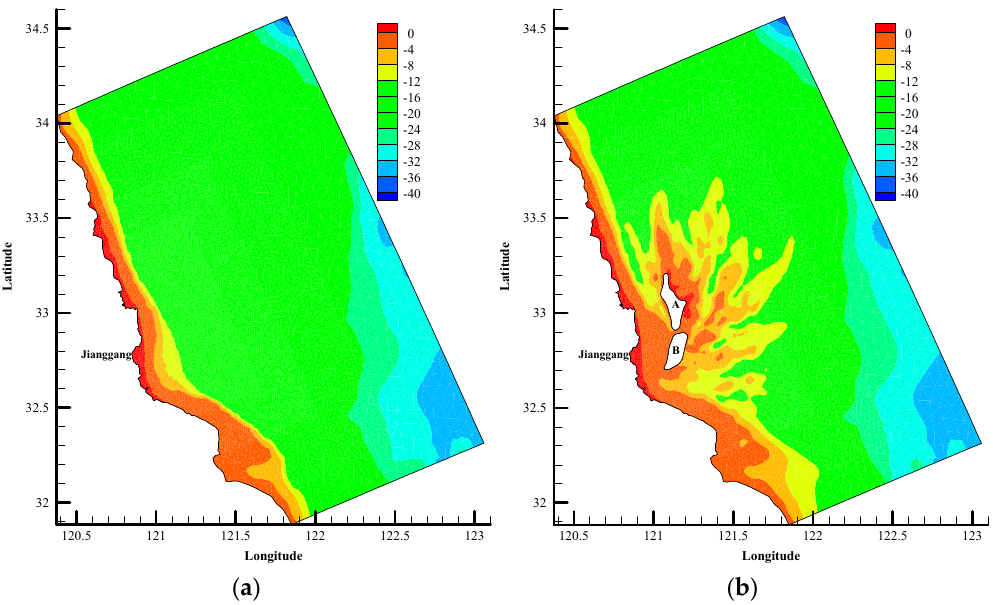
Figure 3. Assumed topographic conditions: ( a ) No radial sand ridges (RSRs); ( b ) partially reclaimed RSRs.